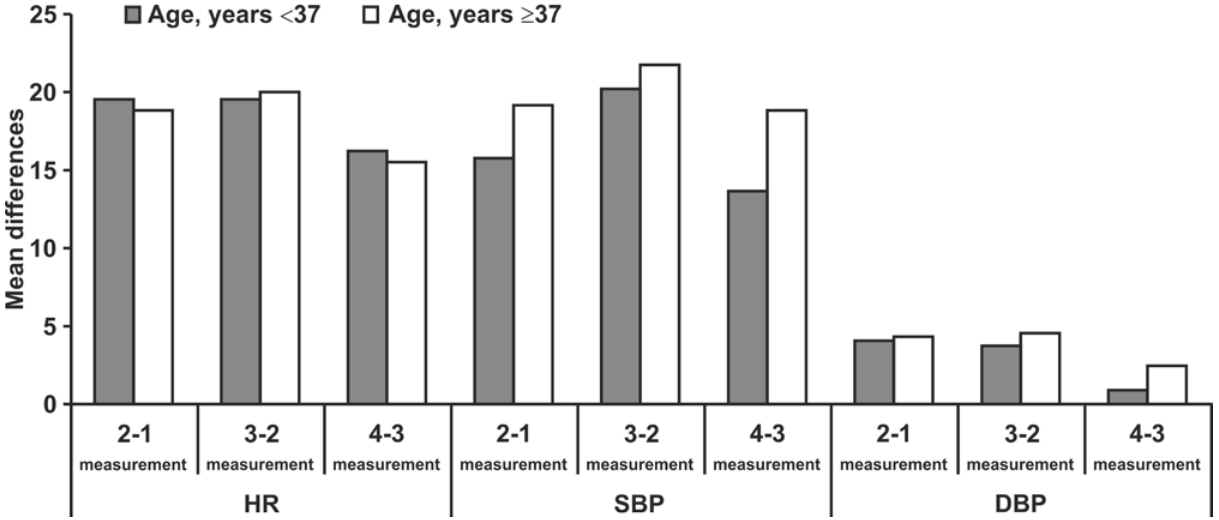
Figure 2: Distribution of mean differences of the subjects’ heart rate, systolic and diastolic blood pressure during physical load according to age groups (times/min;